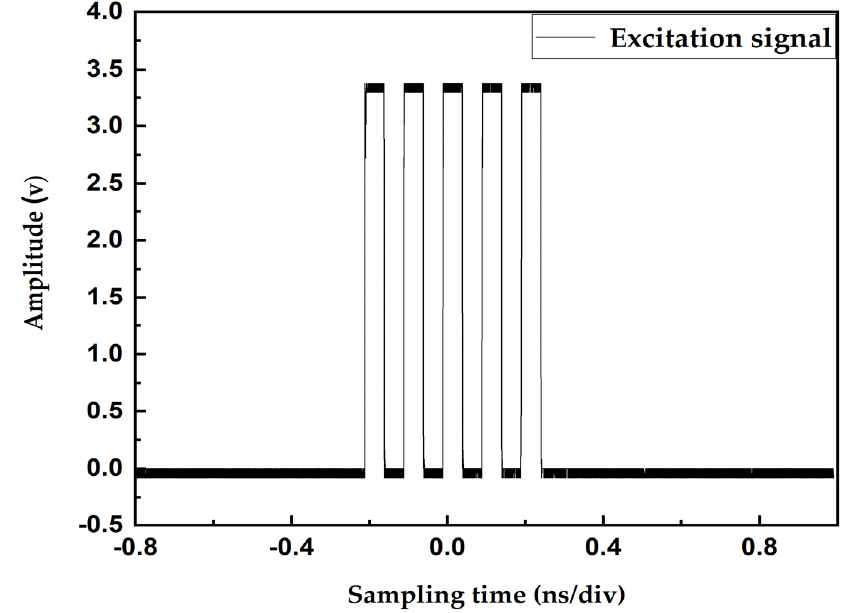
Figure 3. High-precision timing chip (TDC-GP22) circuit generates an excitation signal.